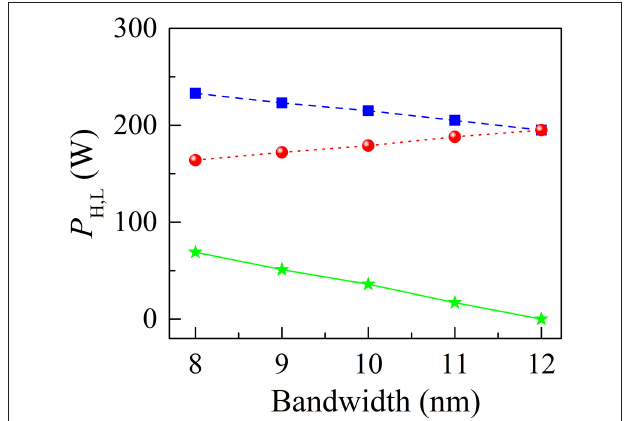
FIGURE 7 | The P H and P L values vs. the filtering bandwidth. Their difference as a function of the bandwidth is shown by the solid green